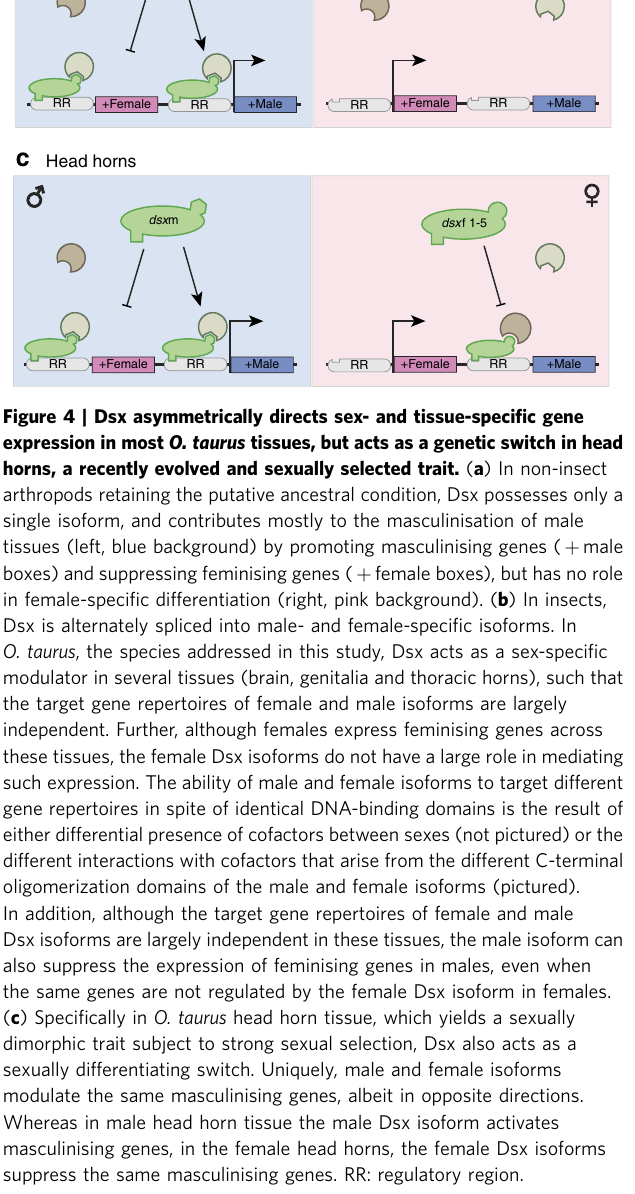
dimorphic trait subject to strong sexual selection, Dsx also acts as a sexually differentiating switch. Uniquely, male and female isoforms modulate the same masculinising genes, albeit in opposite directions. Whereas in male head horn tissue the male Dsx isoform activates masculinising genes, in the female head horns, the female Dsx isoforms suppress the same masculinising genes. RR: regulatory region.